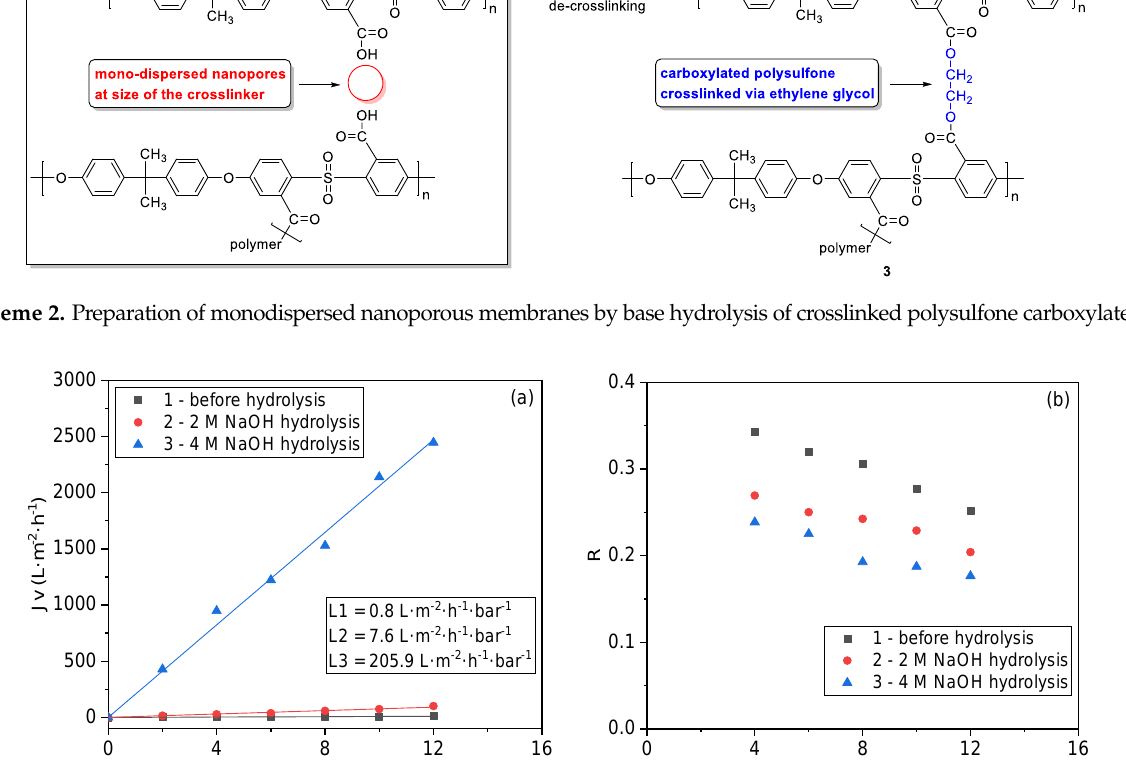
Figure 5. Plots of the flux ( a ) and 0.2% CaCl 2 salt rejection ( b ) against pressure for membranes obtained by hydrolysis with